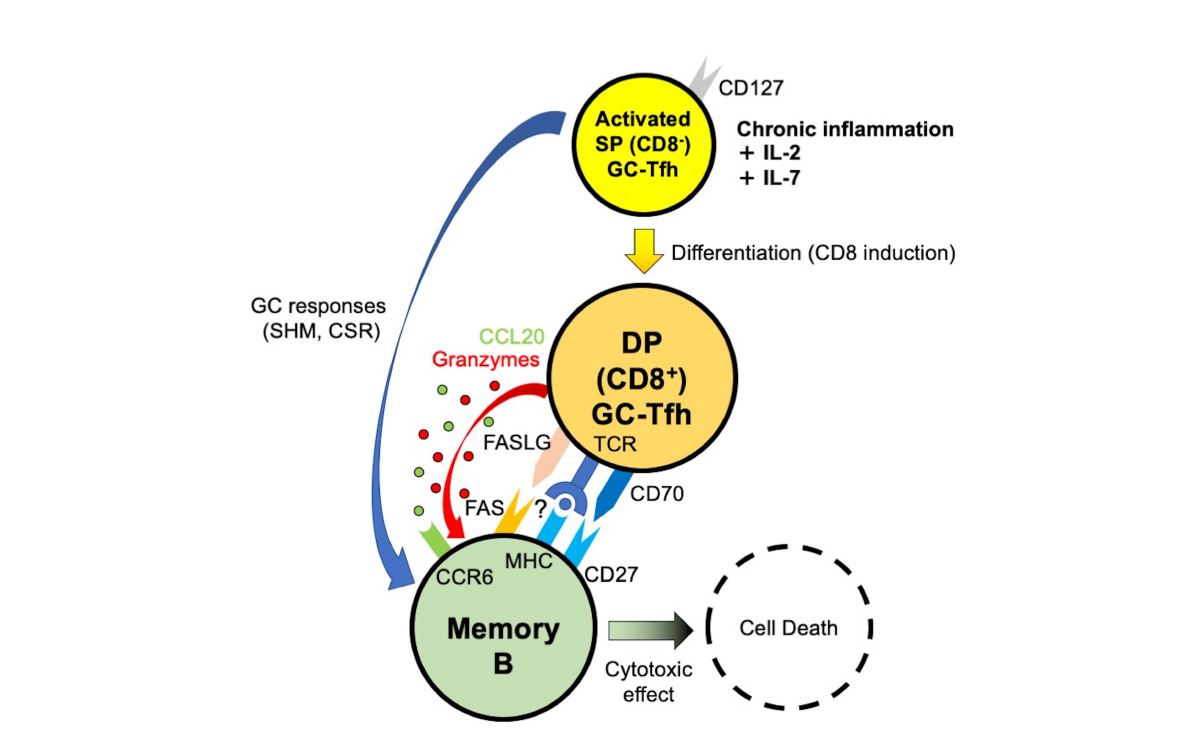
FIGURE 7 Model of DP-Tfh cell function in chronic in fl ammatory lesions of IgG4-RD. SHM, somatic hypermutation. CSR, class switch